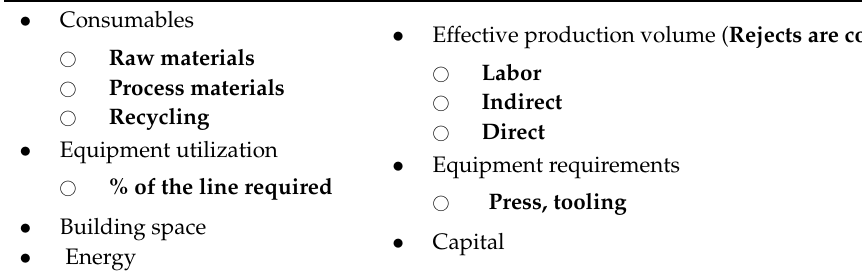
Table 1. Main PBCM elements considered for